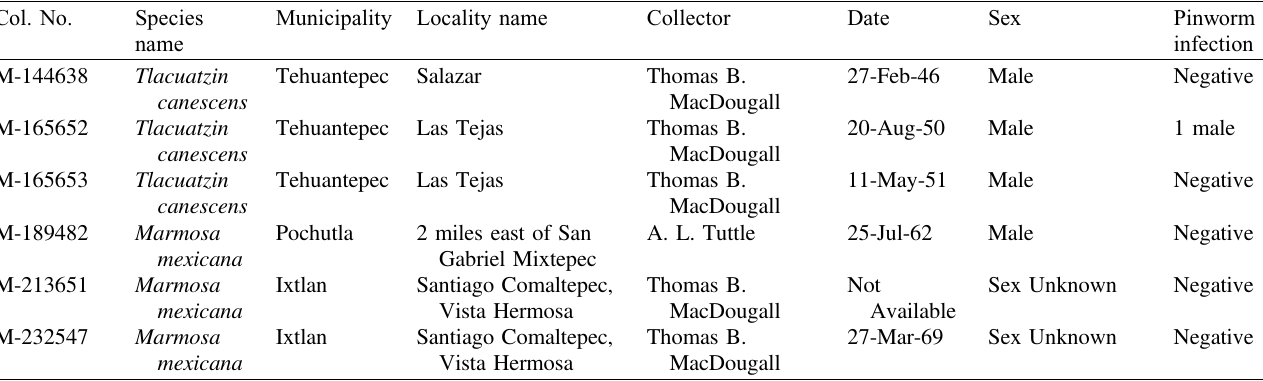
Table 1. Information on gray mouse opossums and Mexican mouse opossums examined for pinworms. Specimens were collected in Oaxaca, Mexico and accessioned in the American Museum of Natural History, New York, NY. Col.